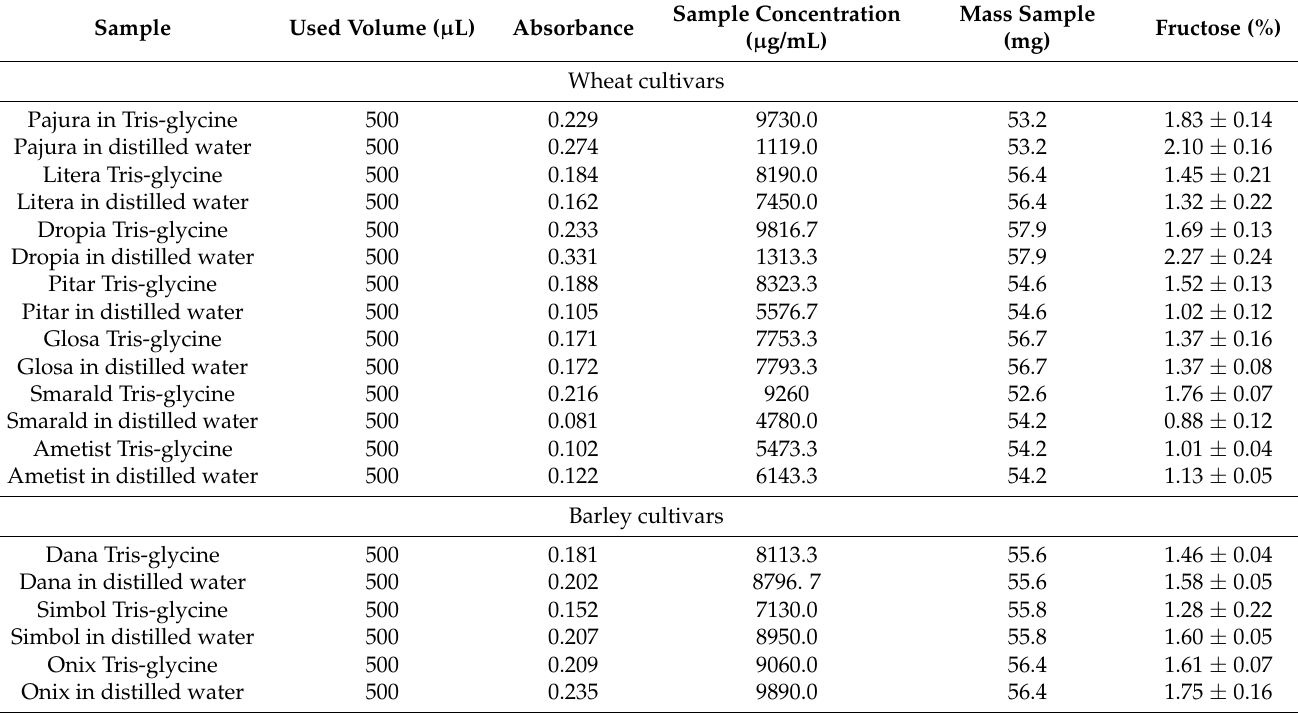
Table 11. Fructan dosage in cereal cultivars (means values ± standard